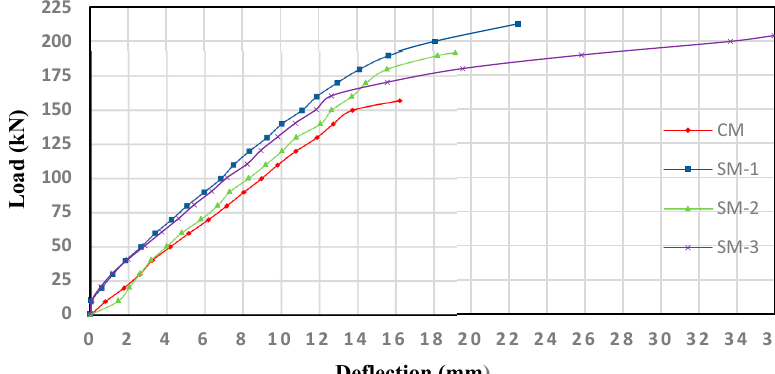
Figure 7. Load–deflection curves for beams of group M.